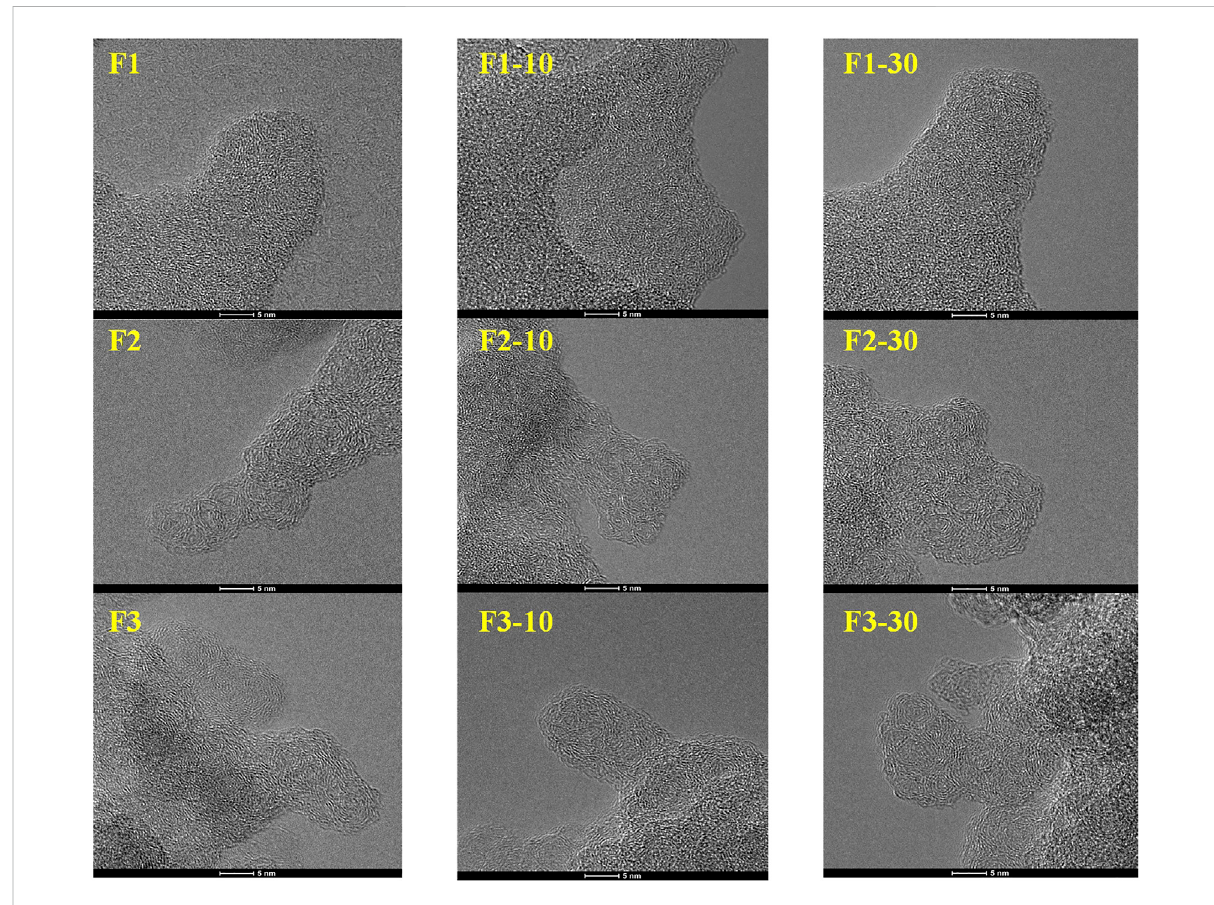
FIGURE 3 Typical HRTEM images of soot in fl ames with different magnetic fi